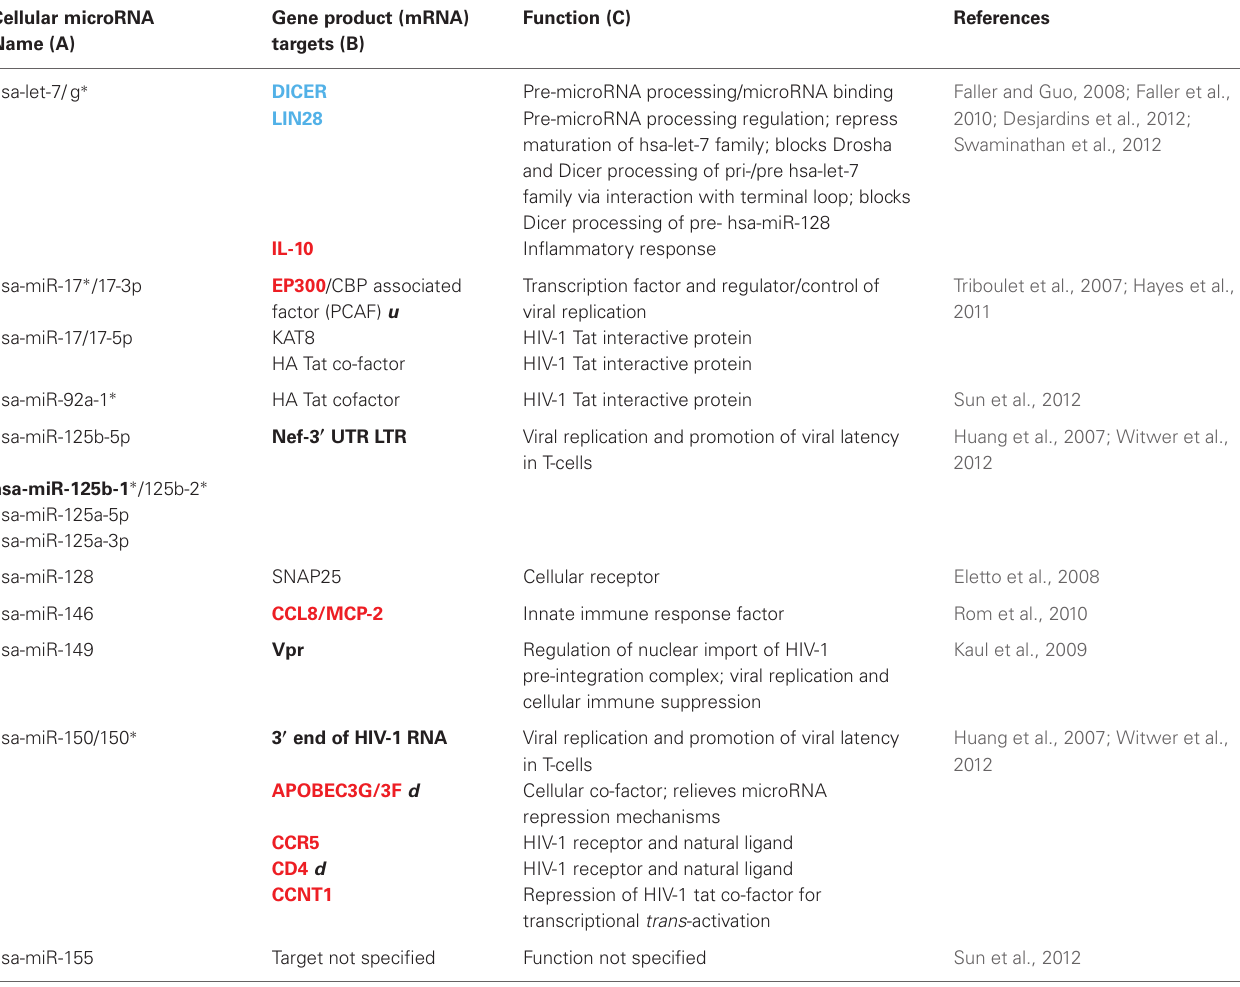
Table 2 | List of published cellular microRNAs and their target HIV-1 and cellular gene products. Cellular